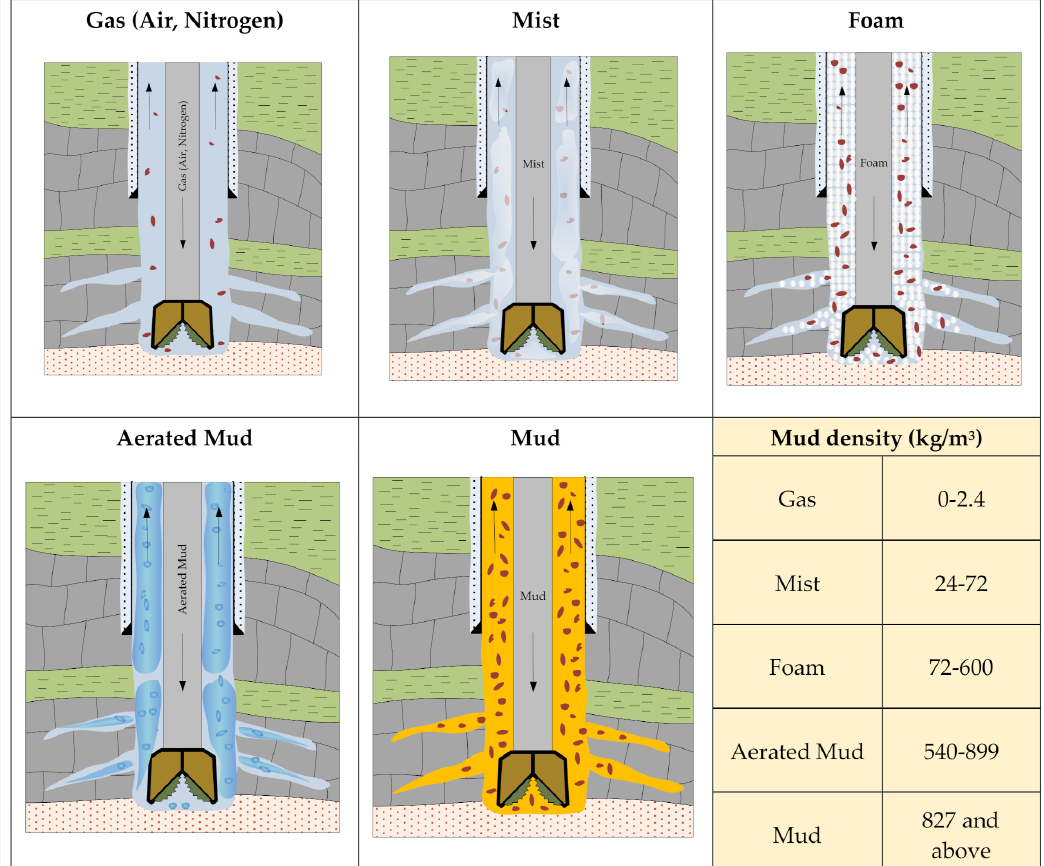
Figure 2. Fluid systems used in underbalanced drilling comparing to conventional